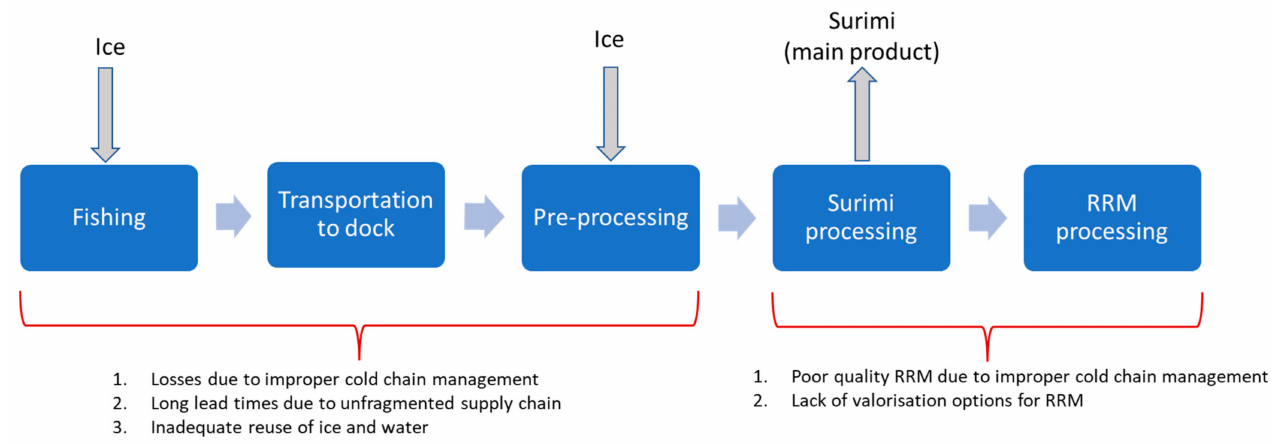
Figure 2. Surimi Supply chain in India and challenges linked to resource